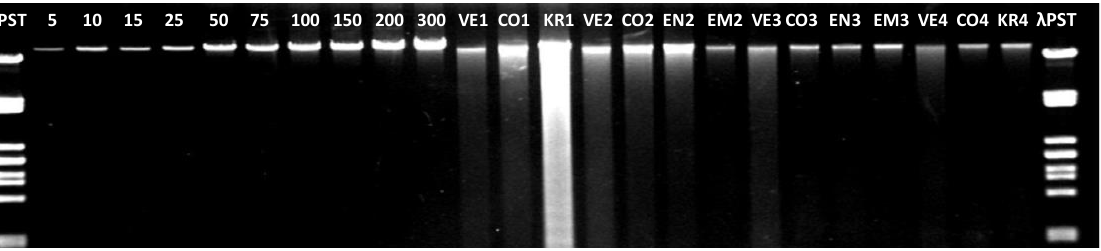
Fig. 1. Estimation of the DNA quantity by loading unknown samples next to Lambda PstI (λ/PstI) samples with a known DNA concentration on an agarose gel. Numbers 5 until 300 represent the DNA concentrations from the λ/PstI) series in ng µl -1 . VE = vegetative part; CO = cob; KR= kernel; EN = endosperm; EM = embryo; the numbers 1 to 4 after these codes represent the sampling